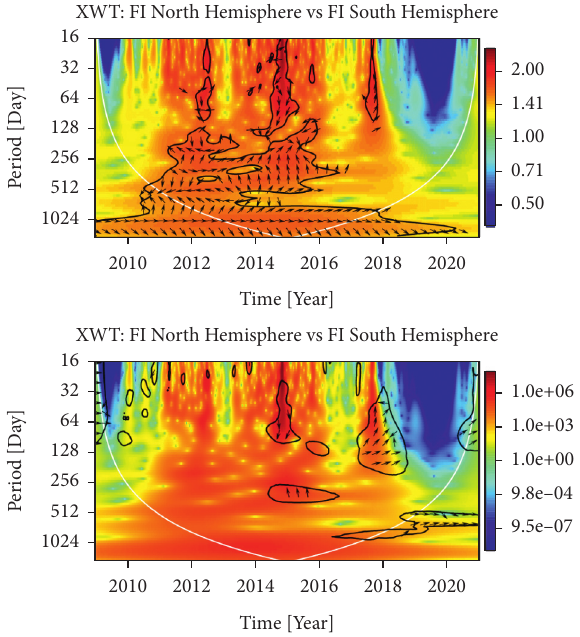
Figure 6: XWT (upper panel) and WTC (lower panel) spectrums between whole disk and Northern Hemisphere FI data. The red color represents regions with the most significant interrelation, while blue colors show the lowest dependence between the selected time series. Periodicities obtained outside of the COI for all wavelet plots are usually not reliable. Arrows in the wavelet coherence plots represent the phase relations between the time series. A zero phase difference means that the two time series move together on a particular scale. Arrows point to the right/left when the time series are in phase (antiphase). Arrows pointing to the right-down or left- up indicate that the first variable is leading, while arrows pointing to the right-up or left-down show that the second variable is